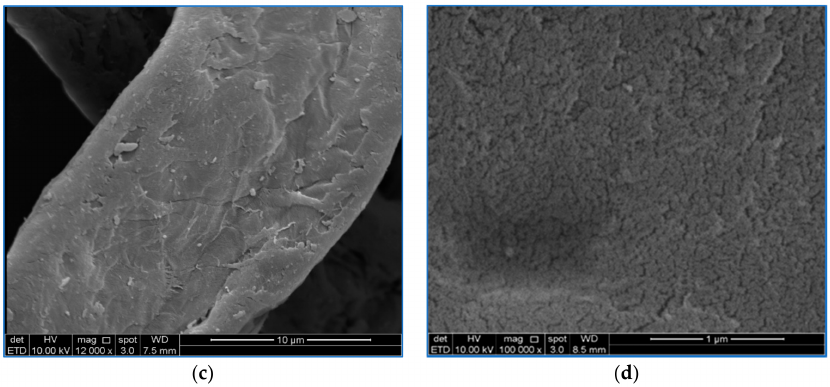
Figure 3. SEM images of ( a ) raw OP-EFB, ( b ) pulped OP-EFB fiber, ( c ) bleached OP-EFB fiber, and ( d ) OPEFB-CNF.